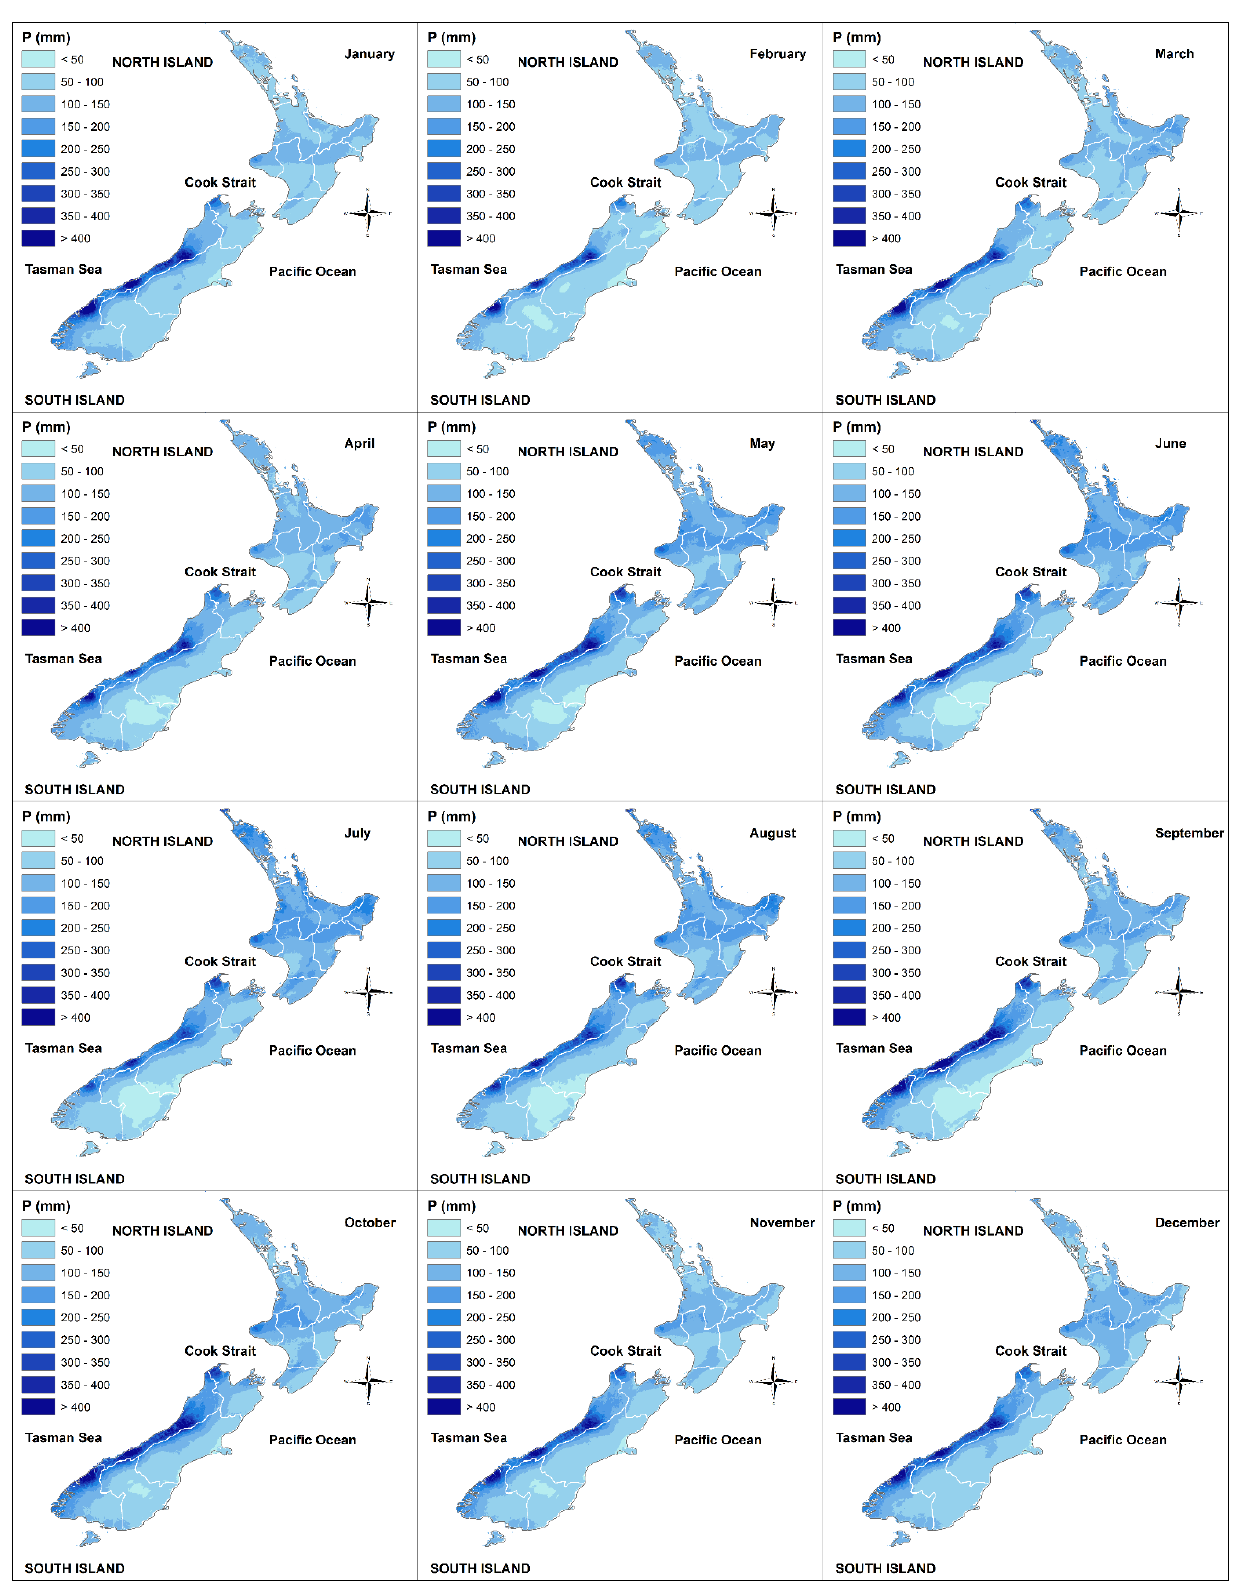
Figure 5. Mean monthly precipitation interpolated using ordinary kriging (OK) method.